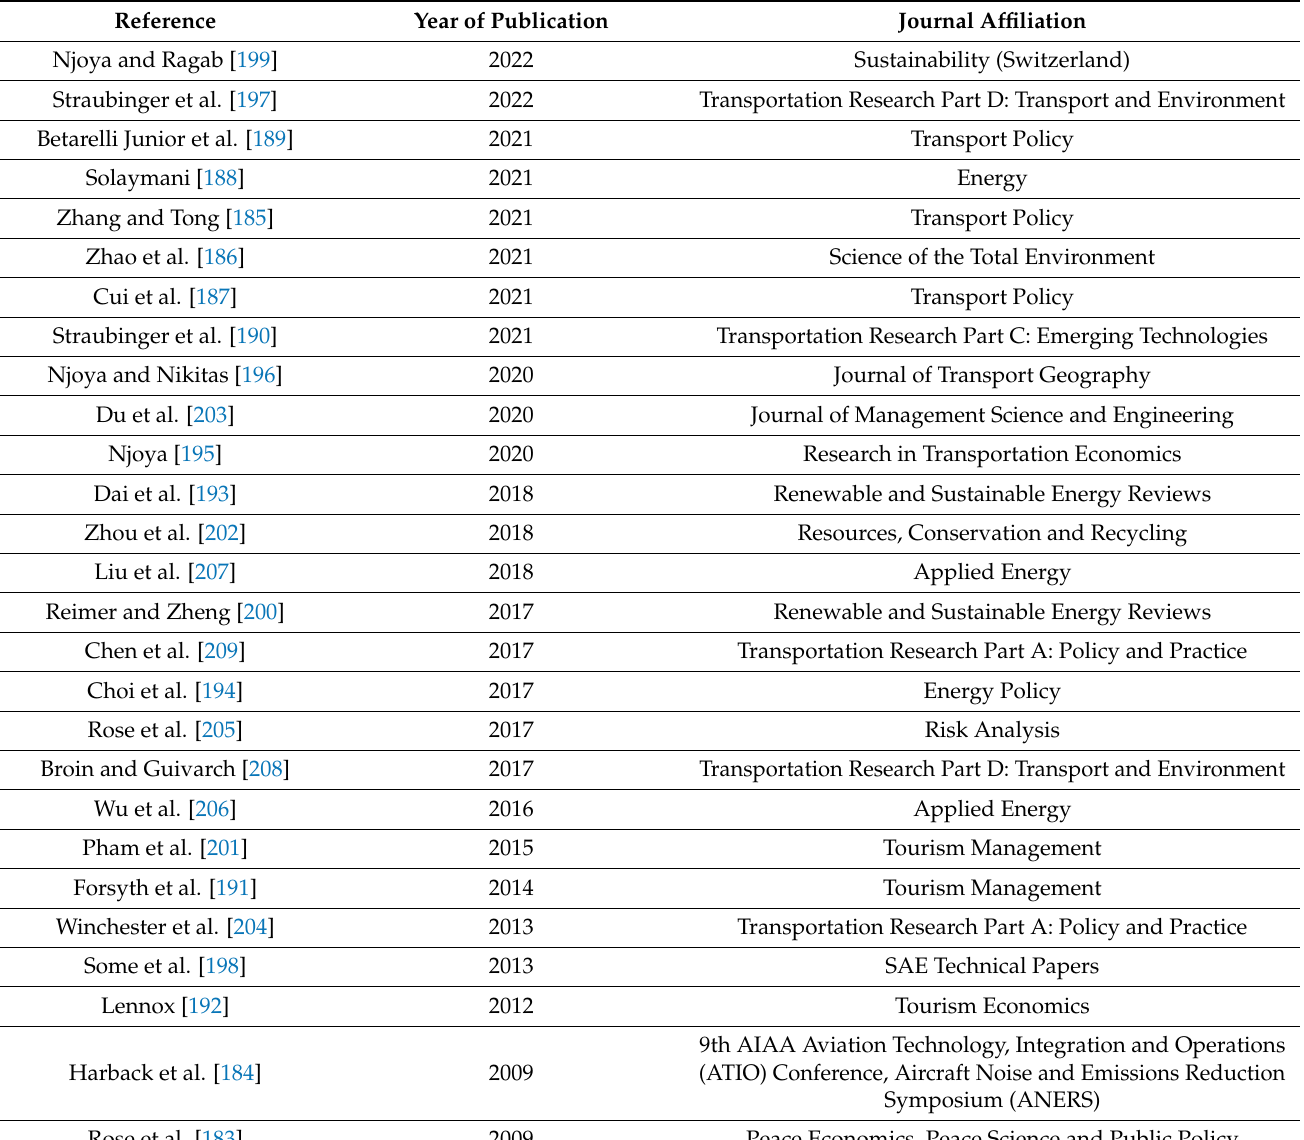
Table A2. Overview of studies applying computable general equilibrium models in the context of